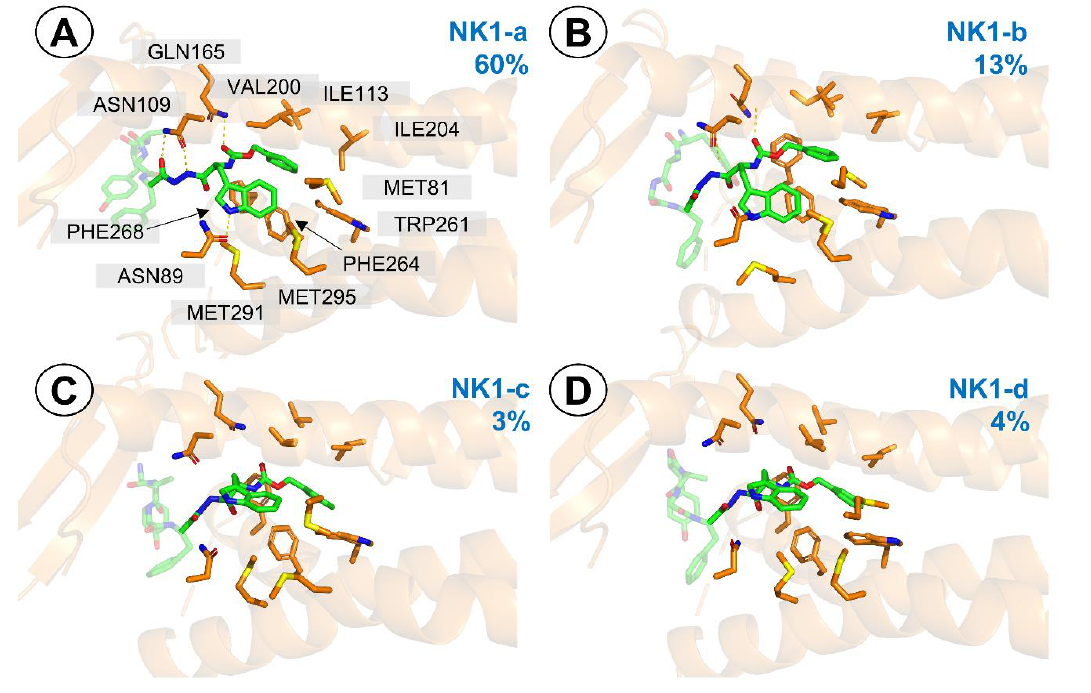
Figure 8. Representative structures for the clusters from MD simulations of AA3266 in the NK1R binding site. Focus on the -NH-NH < -Z-D-Trp part. ( A ) NK1-a cluster, ( B ) NK1-b cluster, ( C ) NK1-c cluster, ( D ) NK1-d cluster. Only a few receptor (orange) side chains and helices are shown for clarity. The blue number is the cluster population.